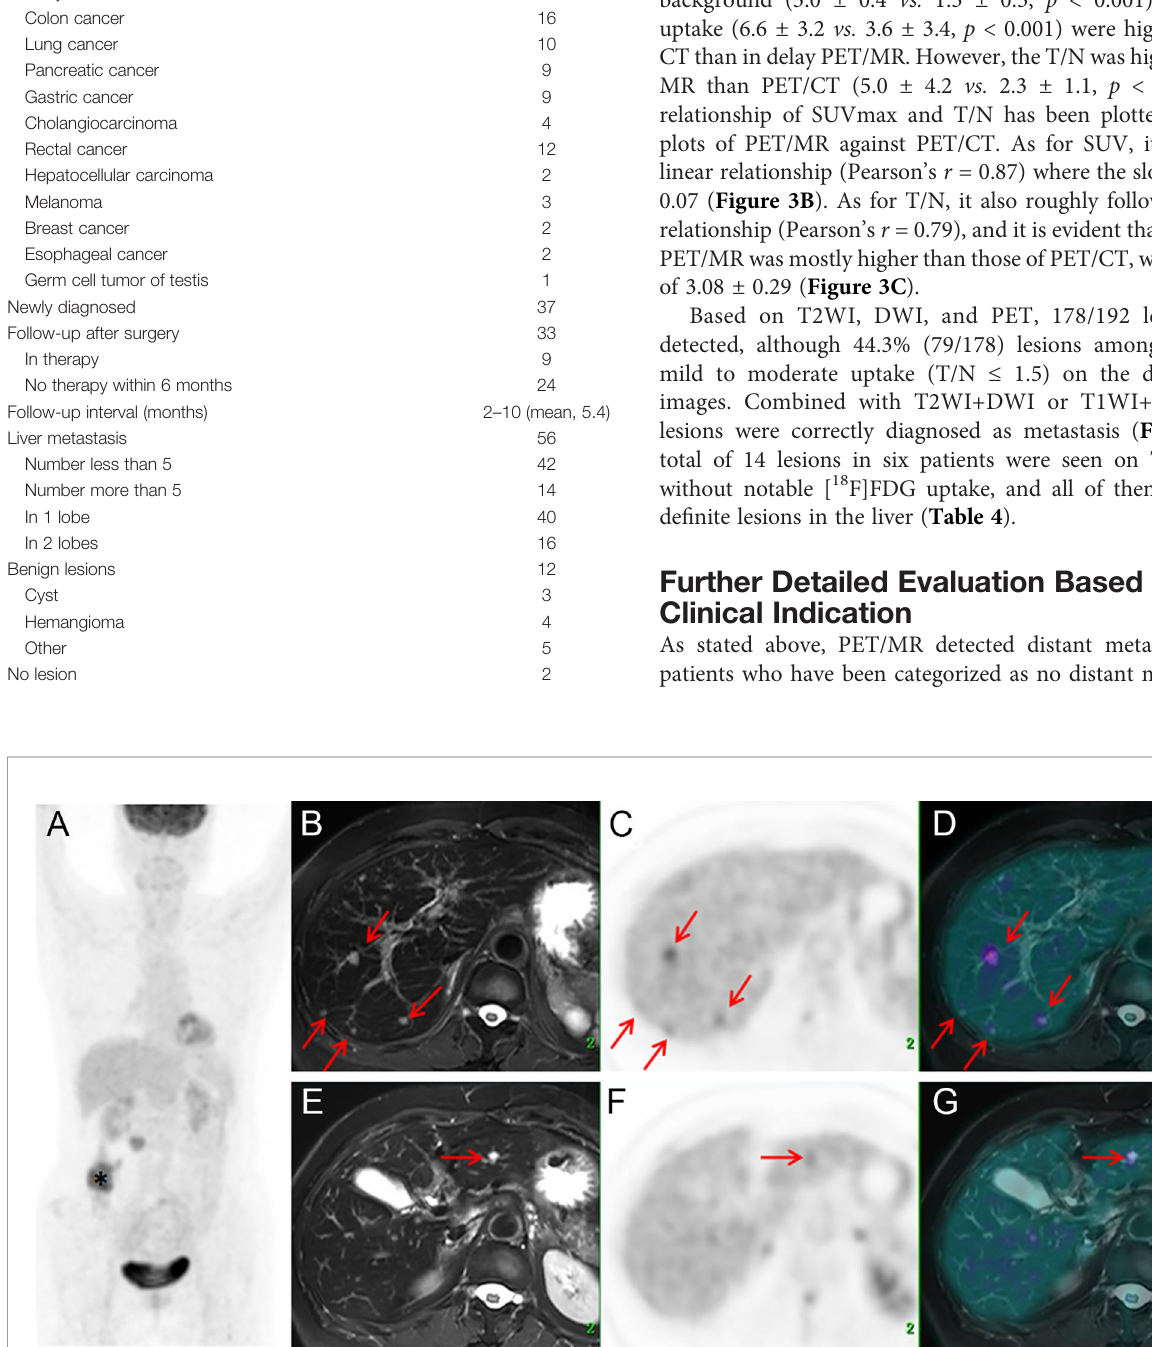
FIGURE 2 | Images of a 64-year-old female with colonic mucinous adenocarcinoma. The MIP (A) of PET/CT showed a primary lesion at the ascending colon (*) with no [ 18 F]FDG foci on the liver. Delayed T2WI, PET, and PET/MR-merged images showed multiple metastases (red arrow) with hyperintensity and hypermetabolism on the right lobe (B – D) and left lobe (E – G)